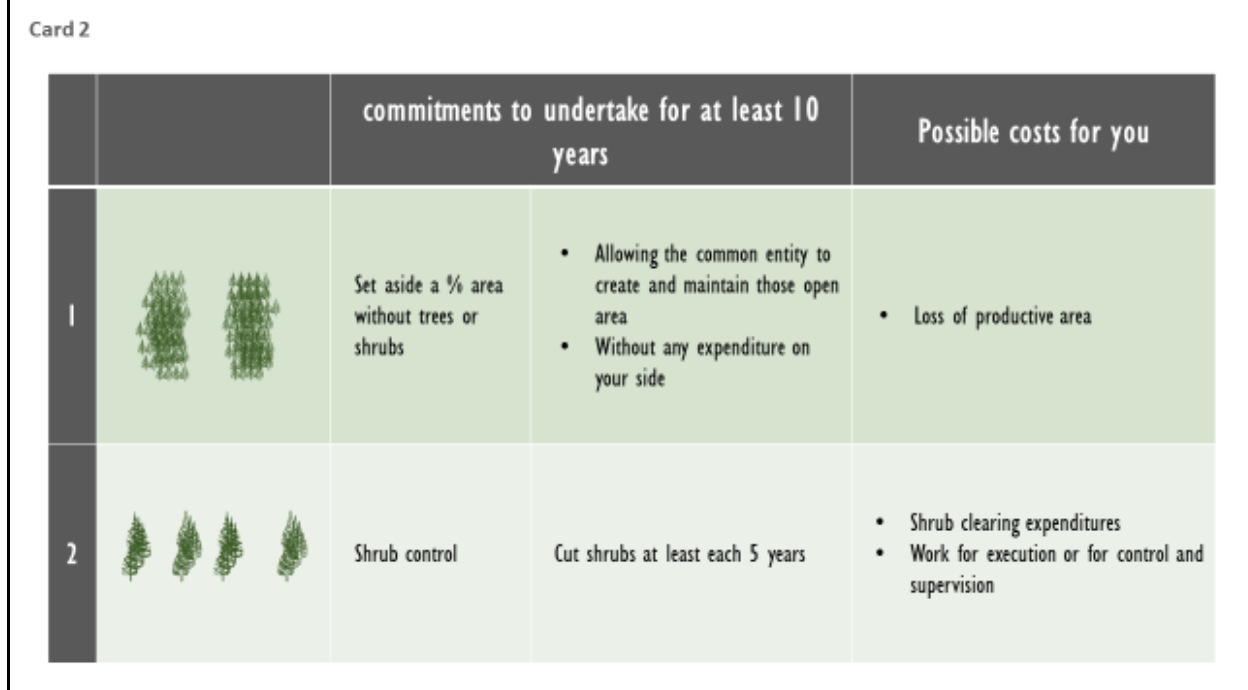
Figure A1. Card 1—Visual presentation of the commitments to be subscribed by the respondent for at least ten years and possible costs, for each commitment. The choice experiment only proceeded after careful presentation of each attribute and all doubts explained.